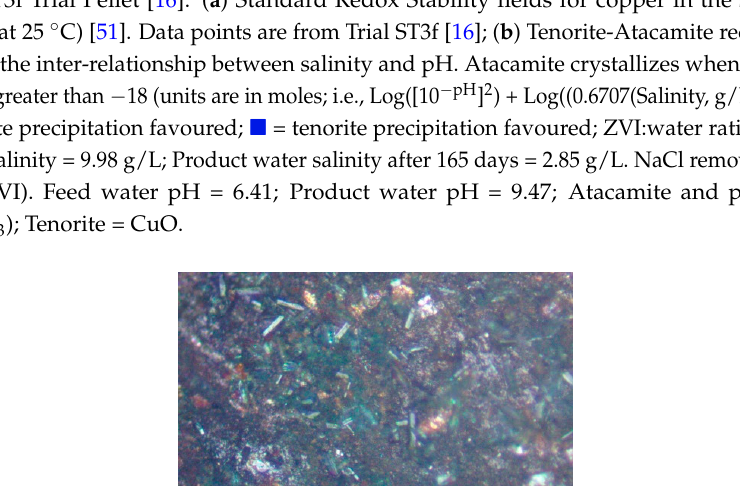
Cu-O-H-Cl (at 25 ◦ C) [51]. Data points are from Trial ST3f [16]; ( b ) Tenorite-Atacamite redox boundary